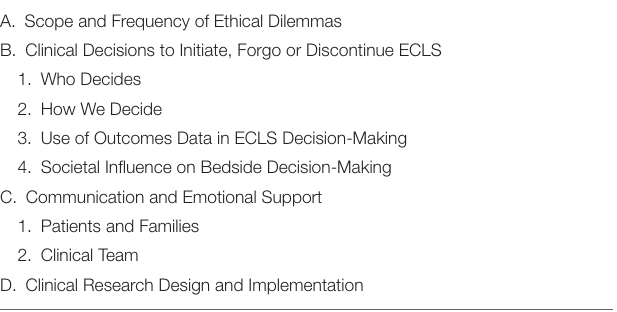
TABLE 1 | Research agenda outline for ethics in extracorporeal life support.